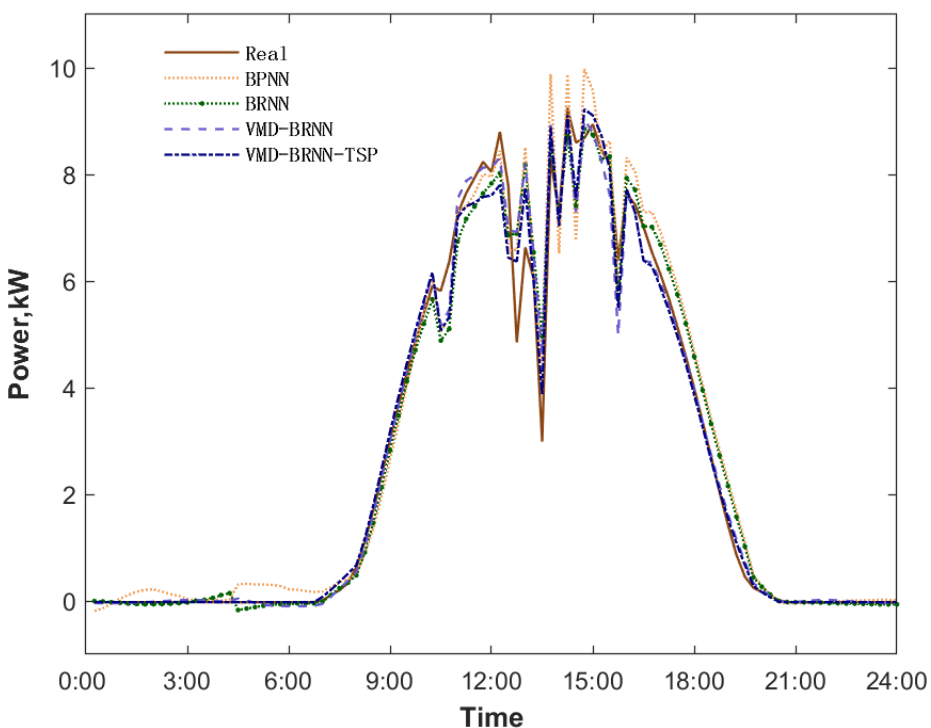
Figure 8. Single-day prediction renderings of output power of 4